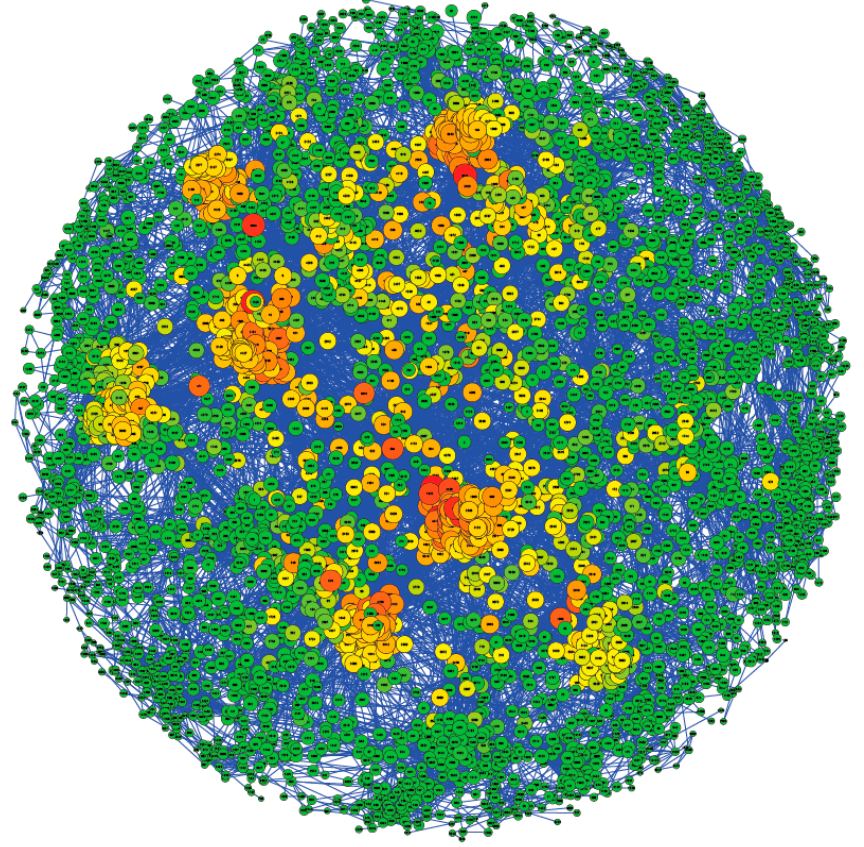
Figure 2. Population structure using the Pedigromics approach. Genomic relationships (>0.2) among the individuals are displayed. Each node represents one animal from the population. The color and the size of the nodes are based on the closeness coefficient, on a green-to-red color scale, with the higher values represented by a large size and red color.